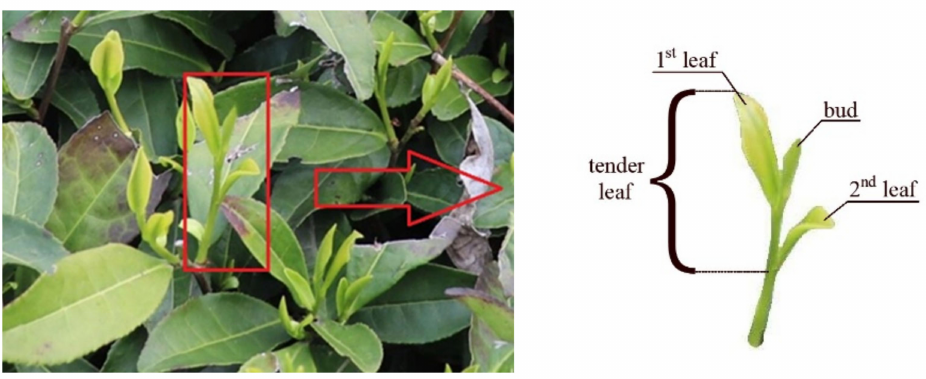
Figure 1. Image of tea tree in tea plantation and schematic diagram of tender